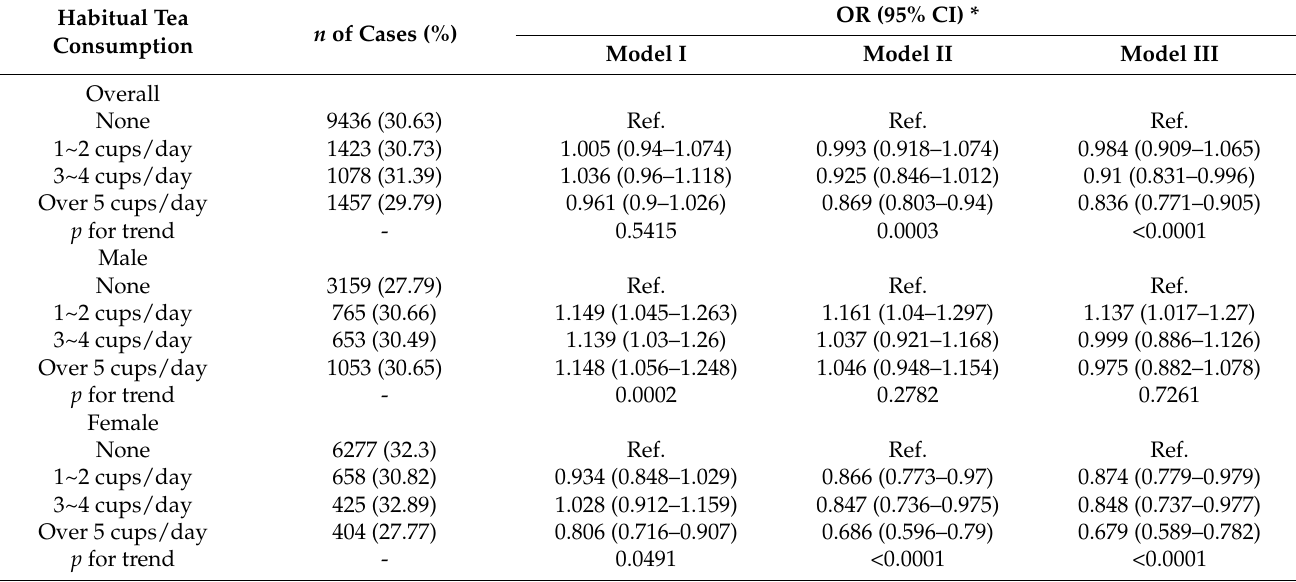
Table 3. Association between MetS and habitual tea consumption among overall, male, and female